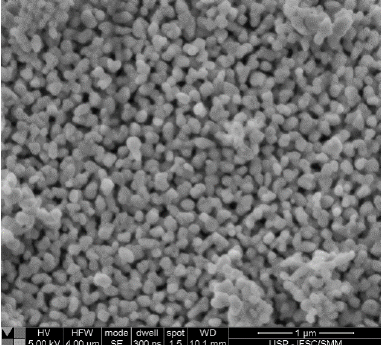
Fig. 6 SEM morphology of the NiWO 4 powders calcined at 700 ℃ /2 h.